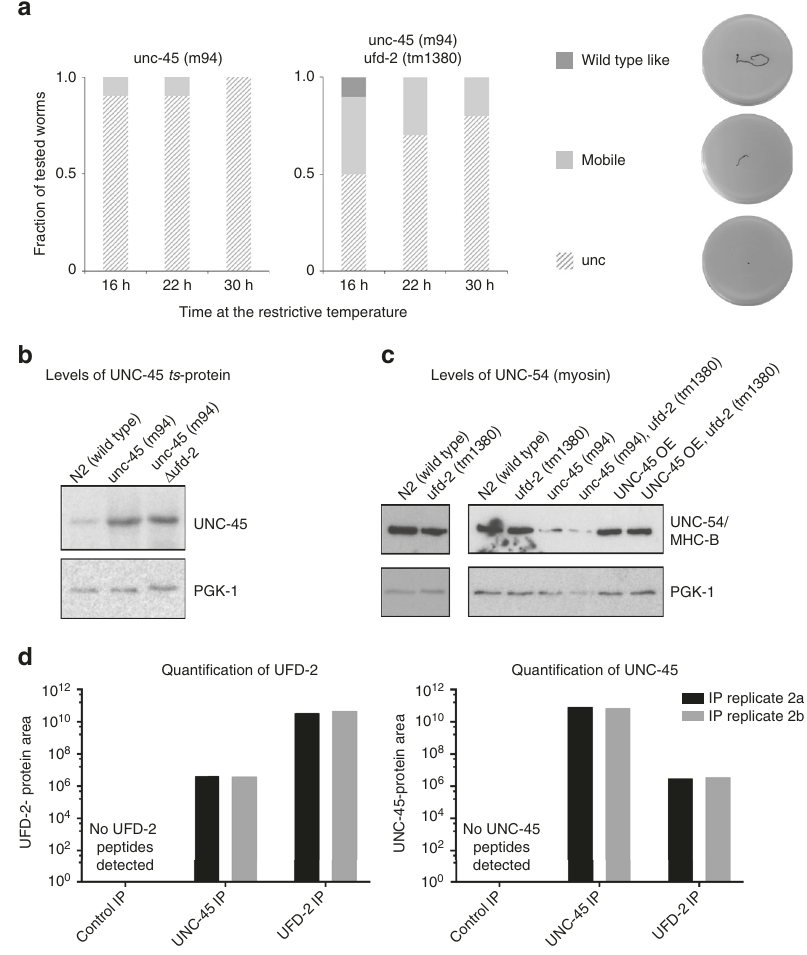
Fig. 3 Functional interaction of UFD-2, UNC-45, and myosin in vivo. a Summary of crawling assays performed with unc-45(m94) and unc-45(m94) ufd-2 (tm1380) adult worms at the restrictive temperature of 23 °C for 60 min. Representative images show tracks generated by a single worm. For quanti fi cation, movement behavior was classi fi ed into three different categories - unc (uncoordinated phenotype), mobile (reduced motility), and wild- type-like motility. b Western blot analysis showing UNC-45 protein levels in wild-type, unc-45(m94) , and unc-45(m94) ufd-2(tm1380) adult worms. PGK-1 was used as a loading control. c Western blot analysis using an MHC-B speci fi c antibody, showing levels of C. elegans muscle myosin in the indicated worm strains. d Quanti fi cation of the protein area of UNC-45 and UFD-2 in anti-UNC-45 and anti-UFD-2 IPs derived from parallel reaction monitoring (PRM). Two technical replicates are shown (two separate sets of IPs from the same lysate). No peptides were detected in control